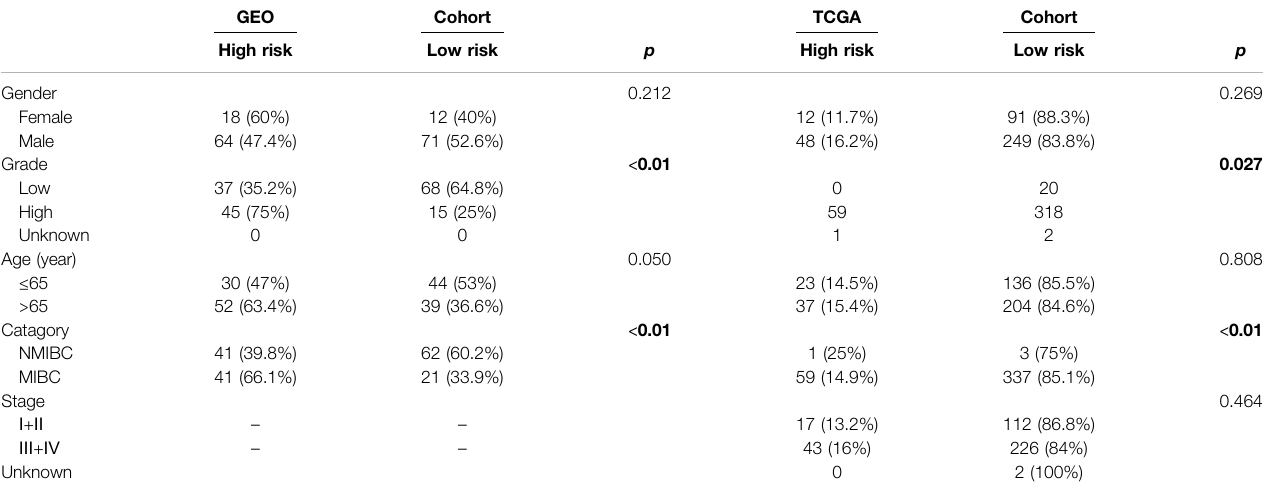
Bold values indicate statistically signi fi cant (p < 0.05).